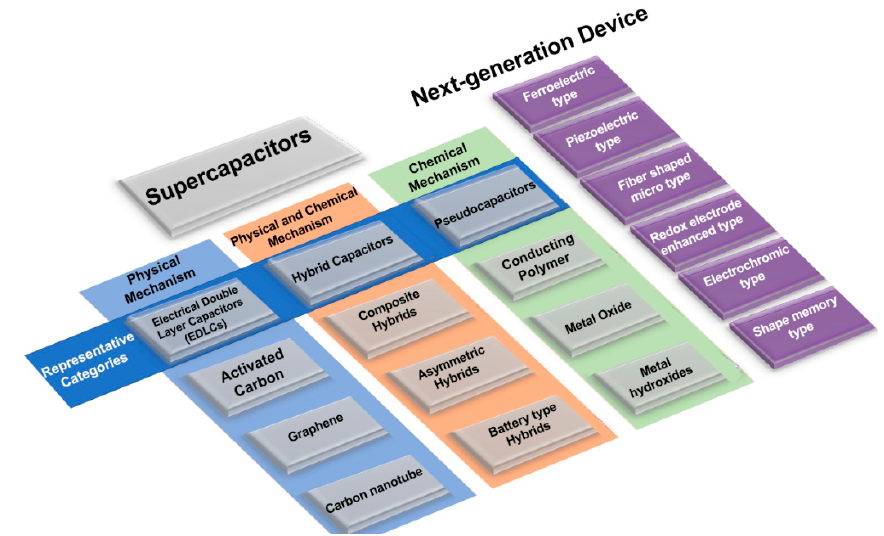
Figure 1. Classification of supercapacitors [24].